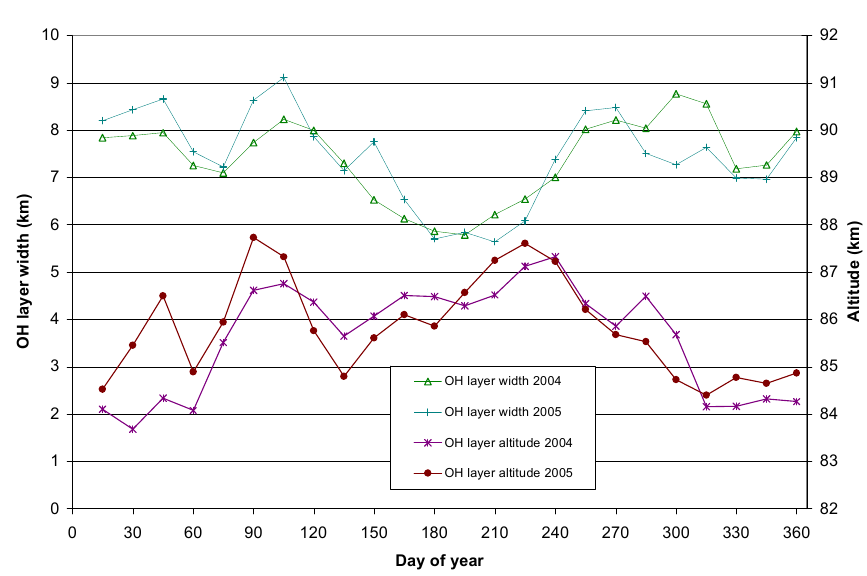
Fig. 11. Altitude of the maximum intensity and full width at half intensity of the SABER OH 1.6 µ m VER profile during 2004 and 2005 at Maynooth plotted as 30-day